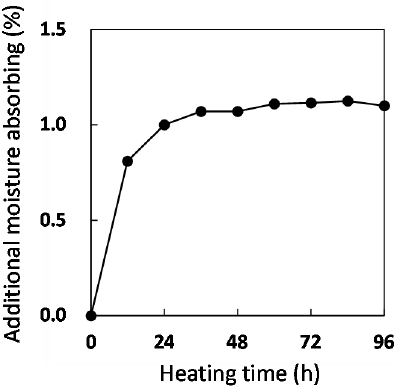
Figure 6. Additional moisture absorbed by non-dry CFRP samples at 120 °C.